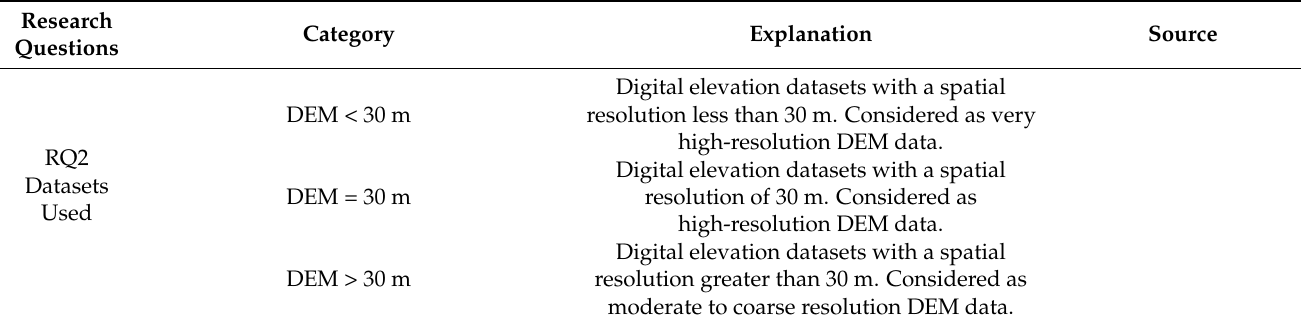
Table 2. Coding scheme used for data extraction.